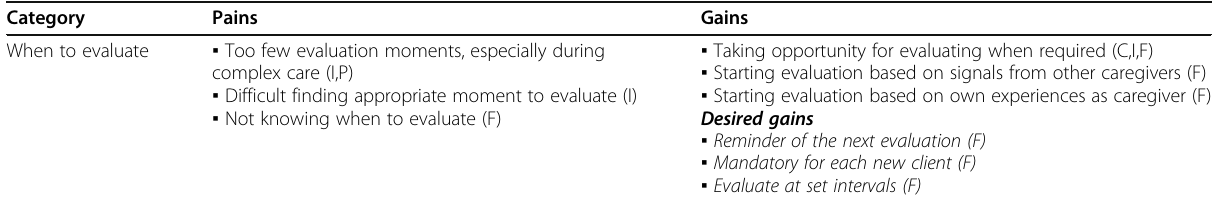
Table 3 Identified pains and (desired) gains for ‘ when to evaluate ’